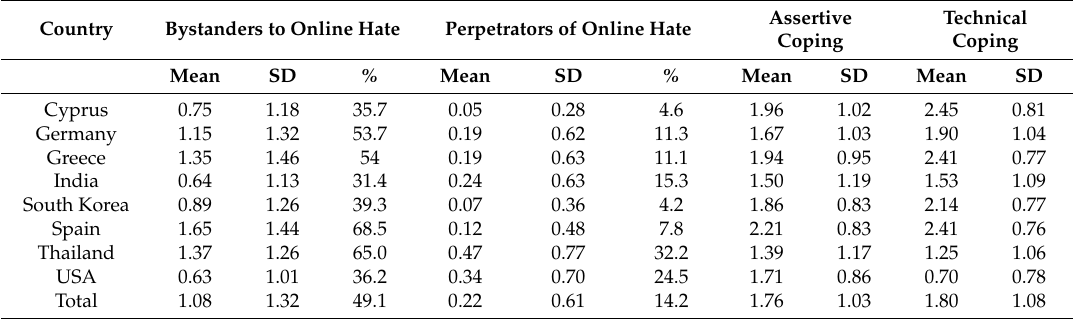
Table 2. Descriptive statistics for online hate bystanders, online hate perpetrators, assertive coping, and technical